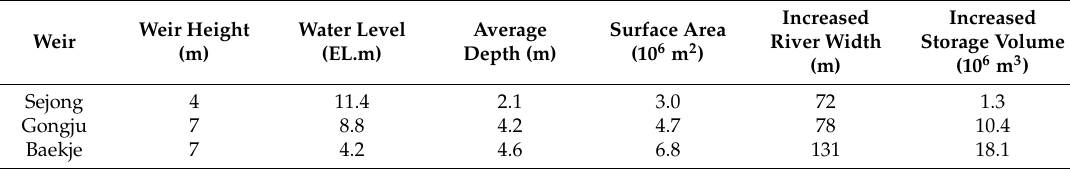
Table 3. Design data on the Geum River weirs